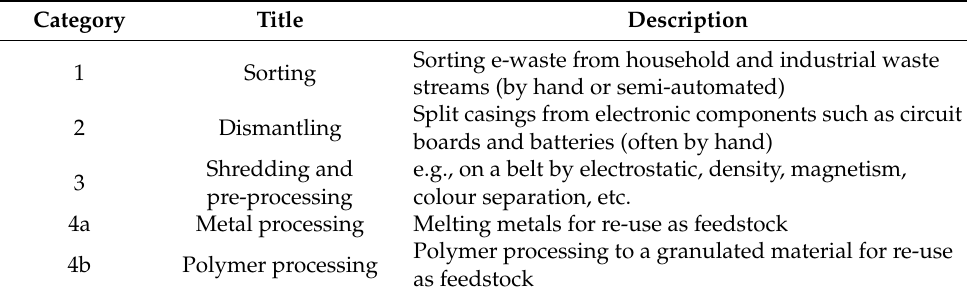
Table 1. Categories of e-waste processing